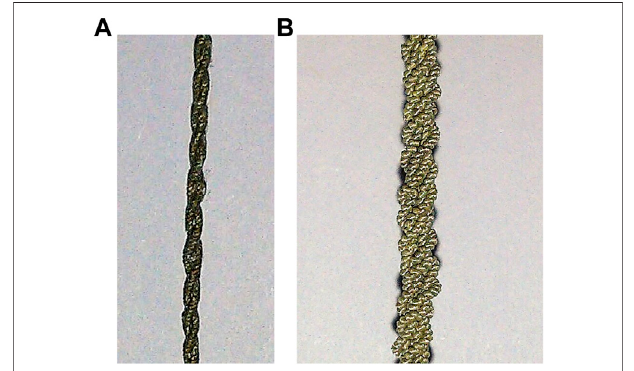
FIGURE1| SCParti fi cialmuscles(RajendranandZhang,2017). (A) One 2-ply SCP muscle coated with silicone and acrylic caulk; (B) three 2-ply SCP muscles twined